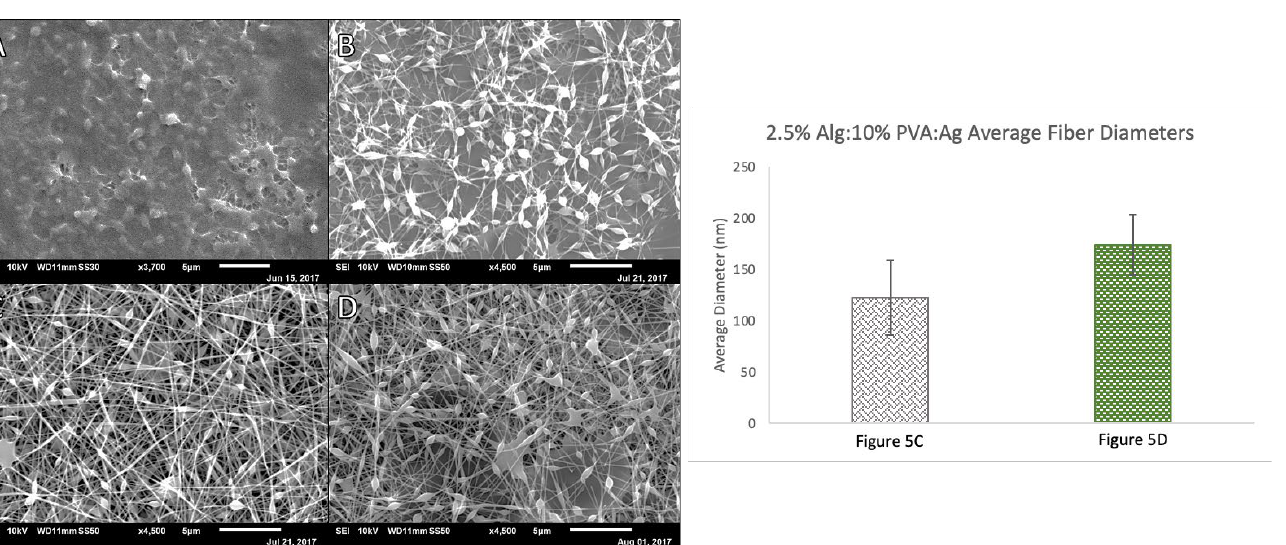
Figure 4. SEM micrographs of 1:1 2.5% Alg: agarose (Ag) samples at various concentrations of agarose spun with a target distance of 100 mm. ( A ) 0.5% Ag at 5.8 μL/min, 25 kV, and 1 mL disp.; ( B ) 0.5% Ag at 7.5 μL/min, 30 kV, and 0.2 mL disp.; ( C ) 0.75% Ag at 5.8 μL/min, 22 kV, and 1 mL disp.; and ( D ) 1% Ag at 7.5 μL/min, 19 kV, and 1 mL disp.